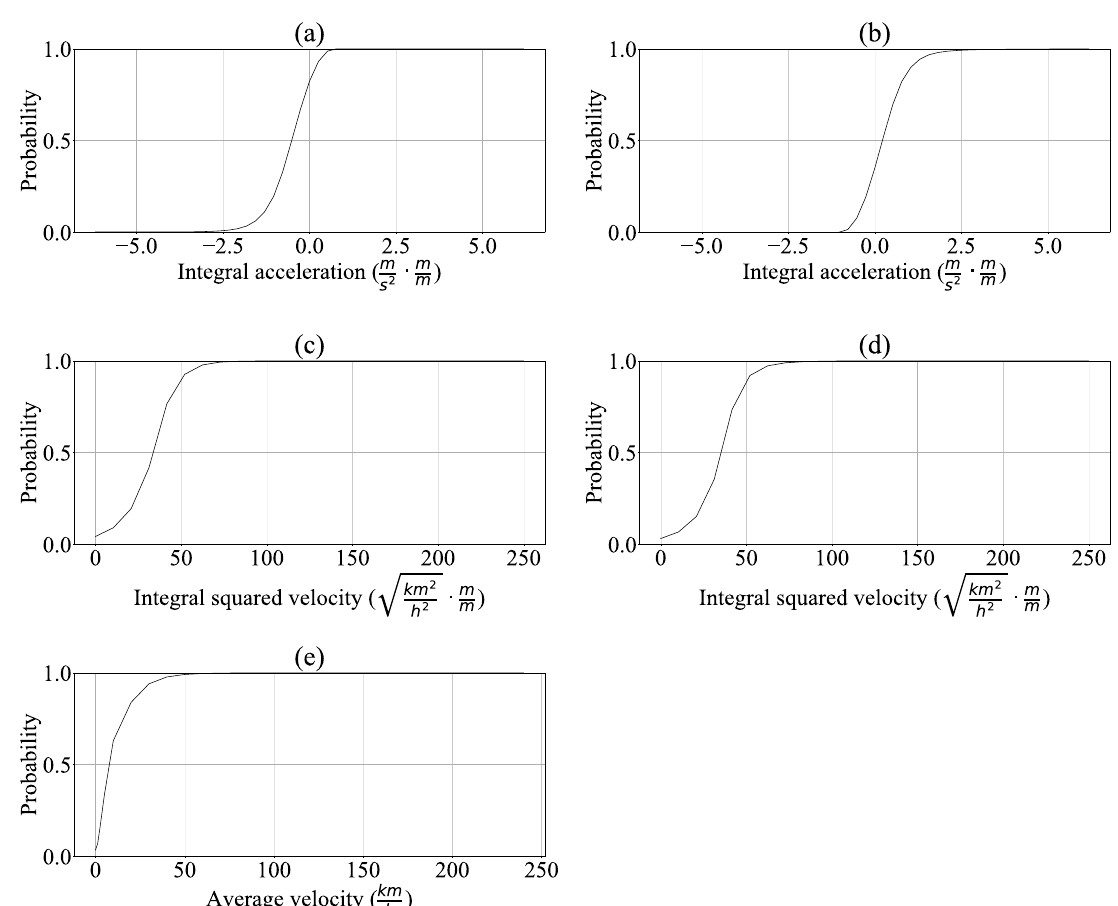
Figure 3. Representative driving profile (DP) map attribute distributions (DPMADs): ( a ) Integral acceleration recuperation (IAR). ( b ) Integral acceleration propulsion (IAP). ( c ) Integral squared velocity recuperation (ISVR). ( d ) Integral squared velocity propulsion (ISVP). ( e ) Average Velocity (AV). Panels (a–d) are displayed normed over distance, and panels (c,d) are transformed into linear space for better